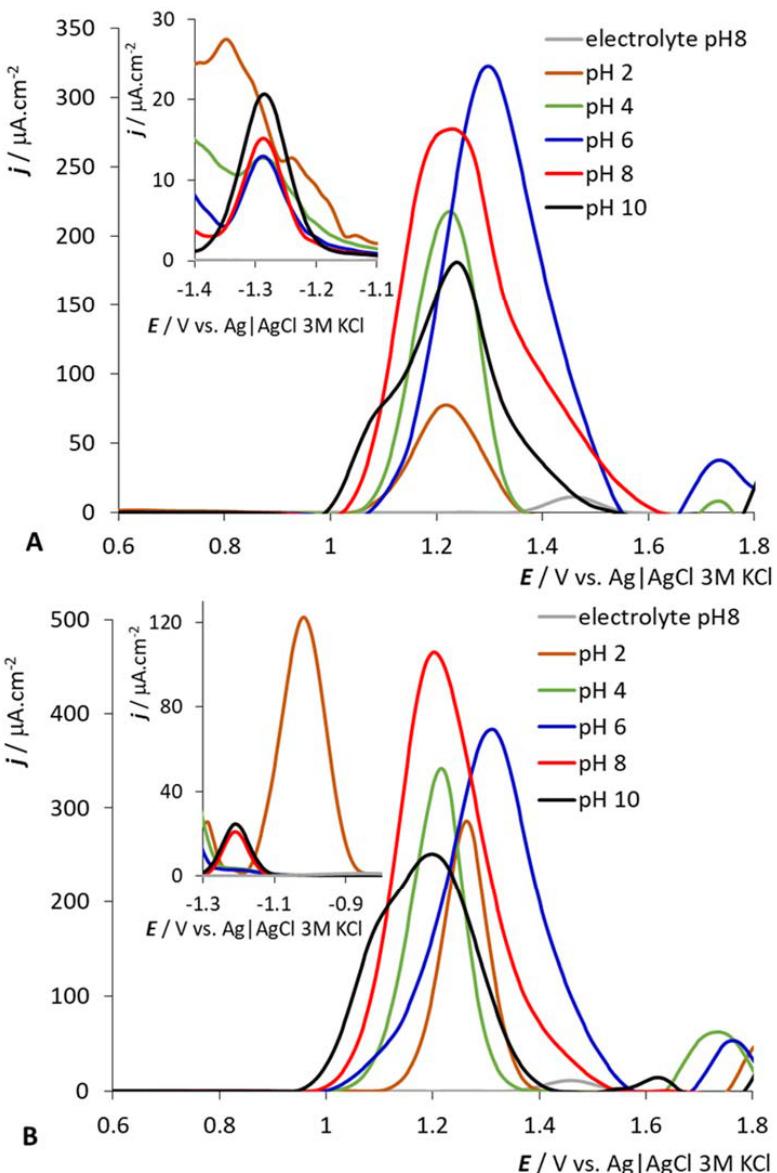
Figure 4. pH dependencies of 200 µ M HOOC-CoSAN ( A ) and (HOOC)2-CoSAN ( B ), GCE. See the captions in the panels for pH value identification.